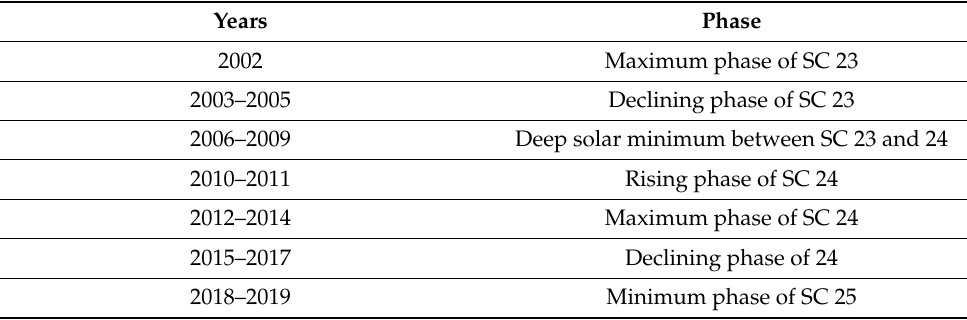
Table 3. Years corresponding to different phases of the considered